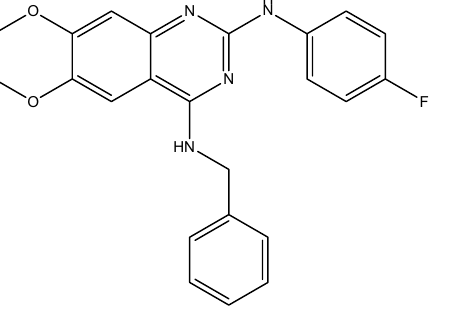
Fig. 4 Design template, N4-benzyl-N2-(4-fluorophenyl)-6, 7-dimeth- oxyquinazoline-2,4-diamine (pEC